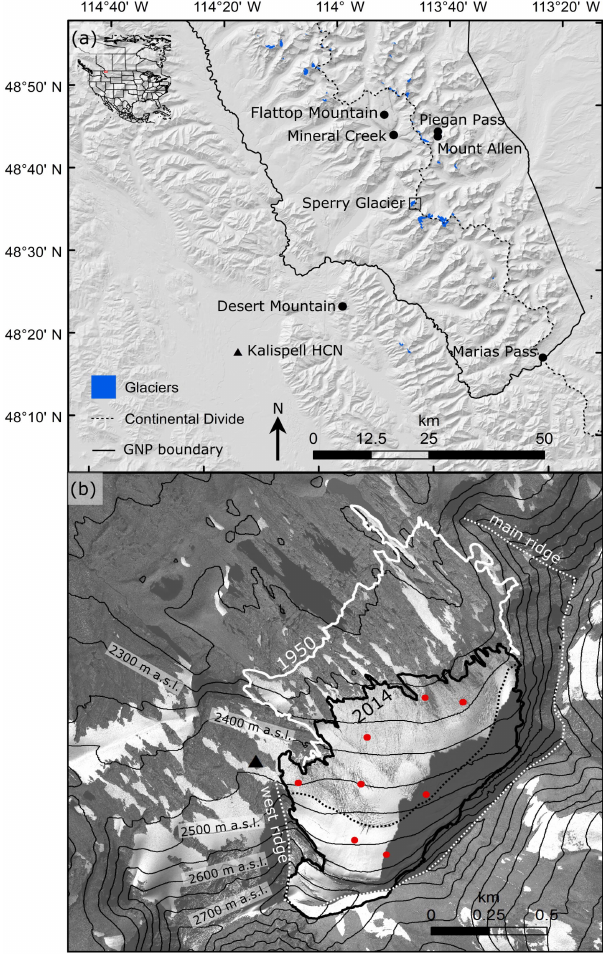
Figure 1. (a) Study area in the US Northern Rocky Mountains, lo- cated just south of the USA–Canada border, as indicated by the red box on the inset map. The 39 named glaciers within and near Glacier National Park (GNP) are shown (blue). The continental di- vide (dashed black line), GNP boundaries (solid black line), loca- tion of Sperry Glacier (small box), Kalispell Historical Climate Net- work (HCN) meteorological station (black triangle), and snow mea- surement sites (black circles) are also shown. (b) WorldView im- agery from 7 September 2014 depicts Sperry Glacier with the 1950 (white line) and 2014 (black line) glacier margins shown. The ap- proximate seasonal snow line (dotted black line) and the main ridge that defines the crest of the cirque headwall above Sperry Glacier, as well as the west ridge which bounds Sperry Glacier (dotted white line), are also depicted. Elevation (m) above sea level (a.s.l.) is rep- resented by thin black contour lines. Stakes where glaciological measurements were made are shown (red), as is the Sperry Glacier meteorological station (black